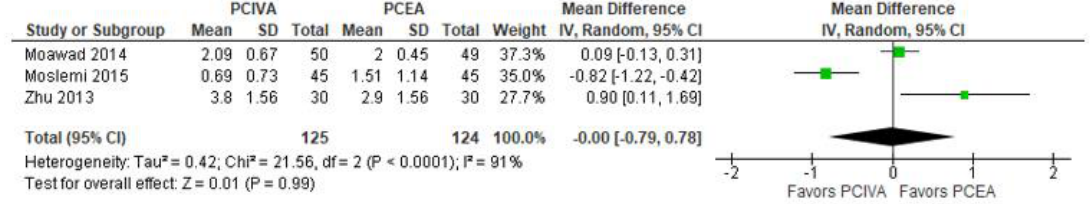
Figure 2. Postoperative pain scores at rest (at 24 h) [17 – 19].